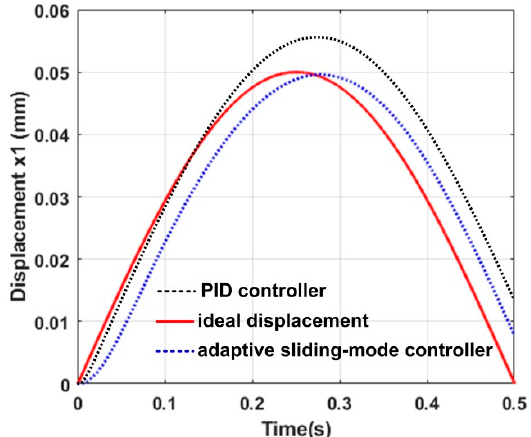
Figure 11. Displacement and speed response of the A-HMB system with the mass parameter variation.